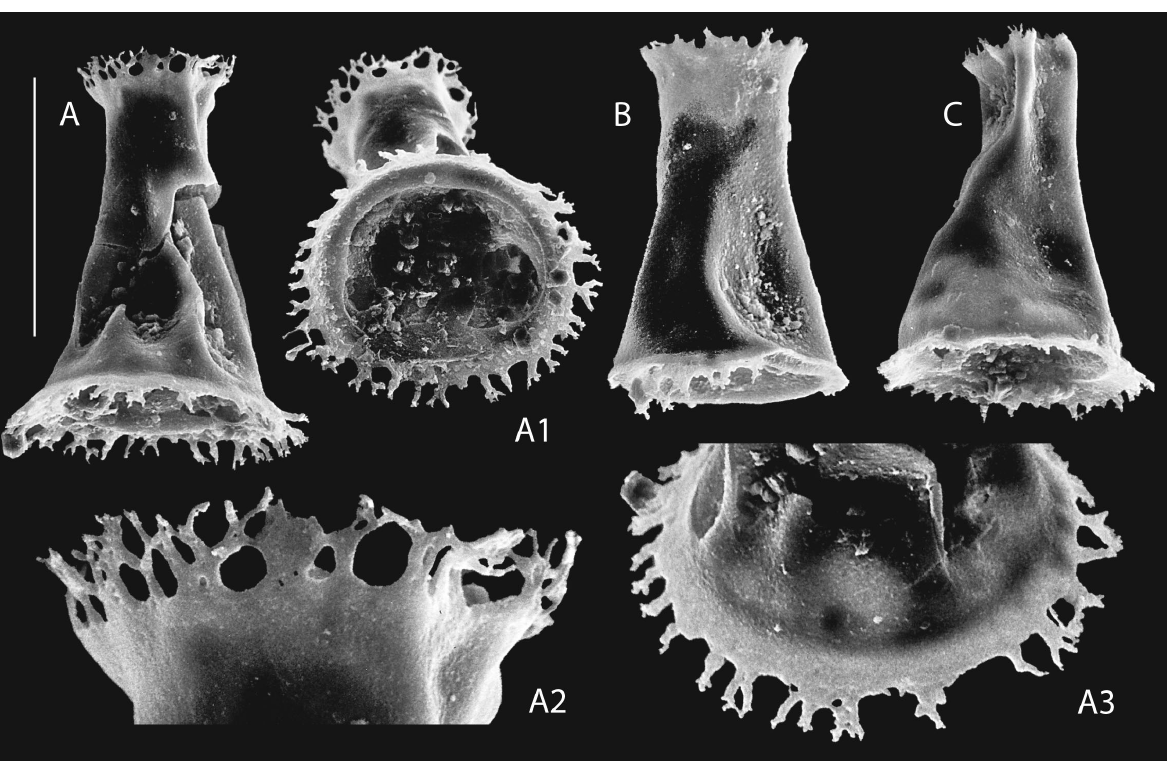
Fig. 1. Selected specimens of Baltochitina delicata sp. nov. Nılvak from Kunda-Aru Quarry, Aseri Stage, sample 0.58(cid:150)0.65 m below its upper boundary. The scale bar corresponds to 100 (cid:181)m. A , Holotype, GIT 644-1, details A1(cid:150)A3. B , Specimen with partly broken collarette and carina, GIT 644-2. C , Specimen with denticulated aperture, GIT